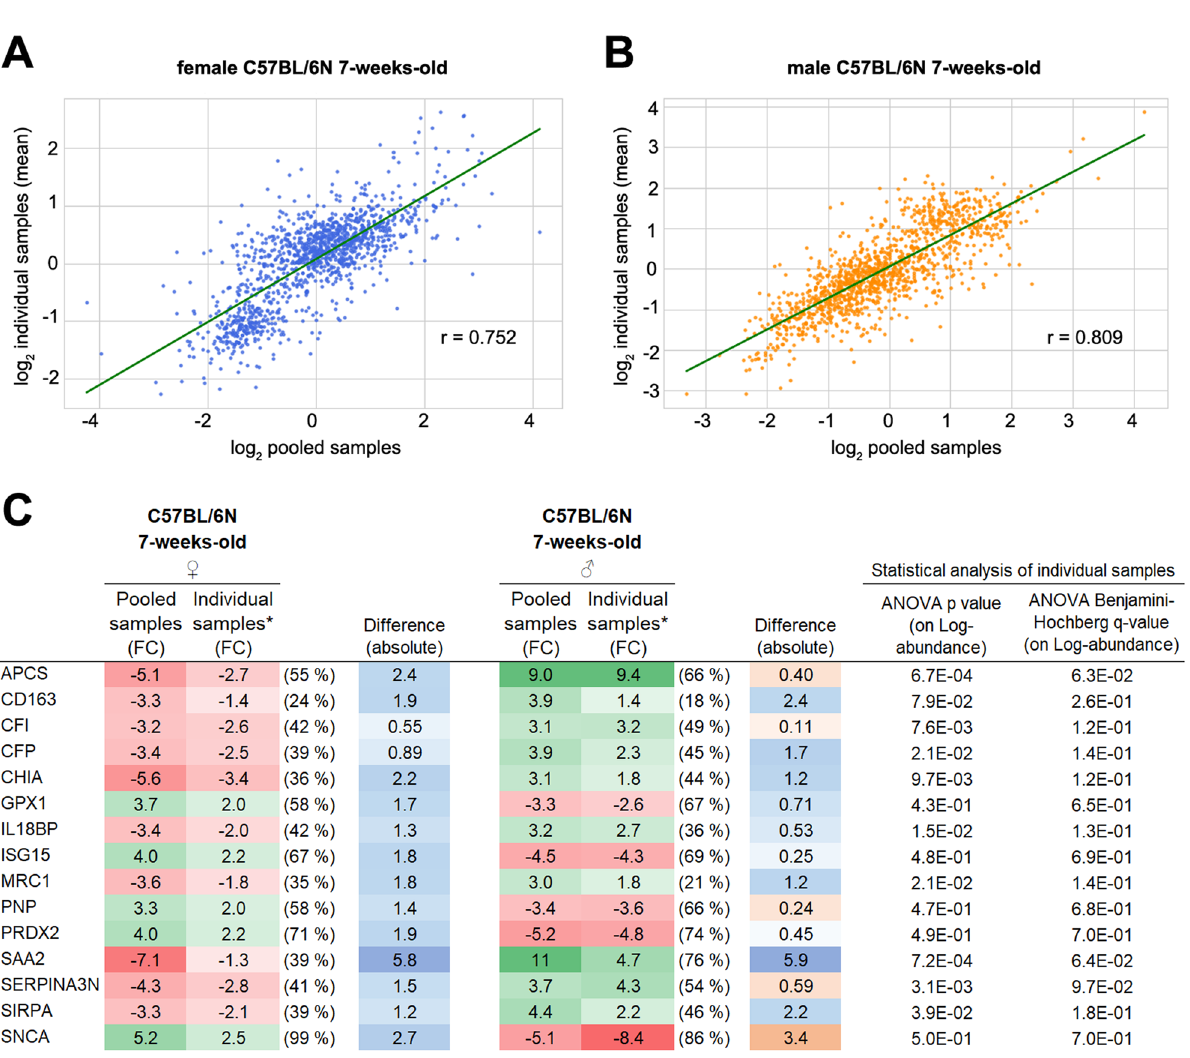
Figure 8. Comparison of pooled and individual sample analysis. The overall correlation between pooled and individual analysis of blood plasma protein 24 h after 0.5 Gy total body irradiation is shown for female juvenile (7-weeks-old) black mice ( A ) and male juvenile (7-weeks-old) black mice ( B ). Note that the data are log- transformed and mean values for individual samples are shown. A representative protein-specific comparison of differential abundance obtained from pooled or individual analysis is shown for 15 randomly selected proteins with immune associated functions ( C ). Note that fold change (FC) is expressed in linear space. *Mean value; standard deviation (SD, parenthesis) for individual sample analysis is given as mean SD value for irradiated and control groups. Blue and orange indicate that relative abundance is higher or lower in pooled analysis than in individual analysis, respectively. Please note that presented data is normalized to respective unirradiated control